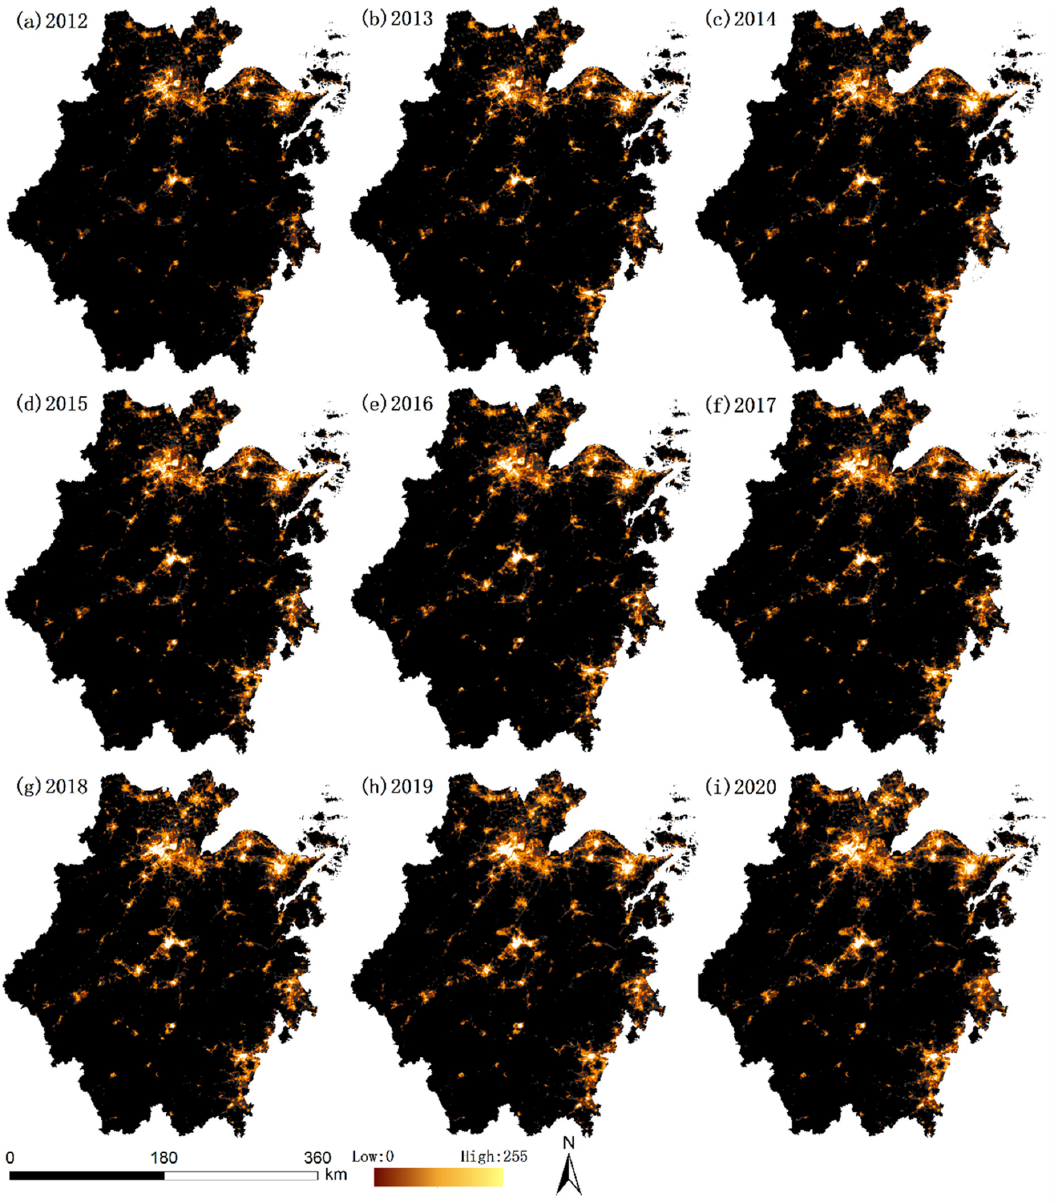
Figure 3. Results of the NPP/VIIRS nighttime light image normalization in Zhejiang Province